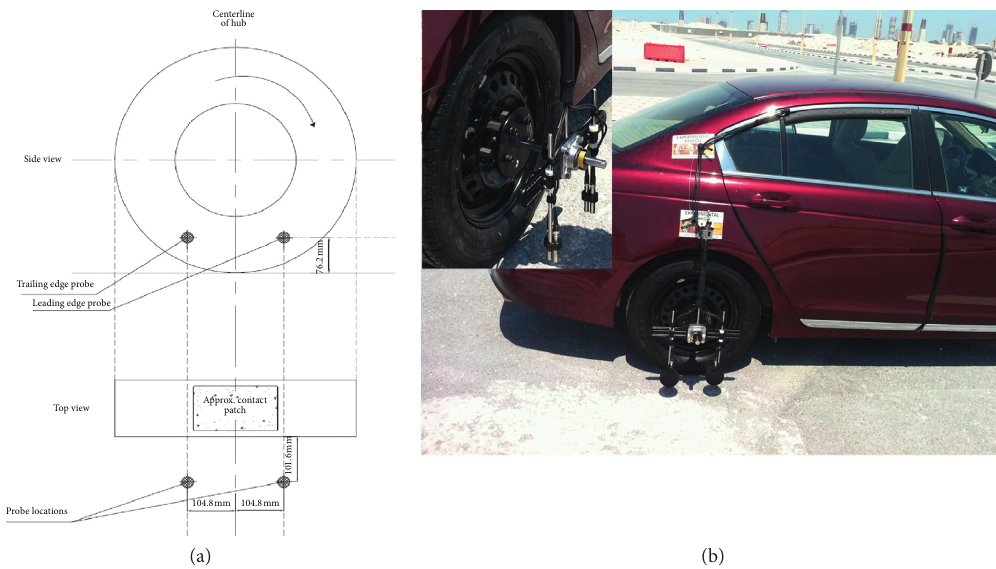
Figure 1: The OBSI testing setup. (a) Schematic diagram of probe locations. (b) Instrumented experimental vehicle.